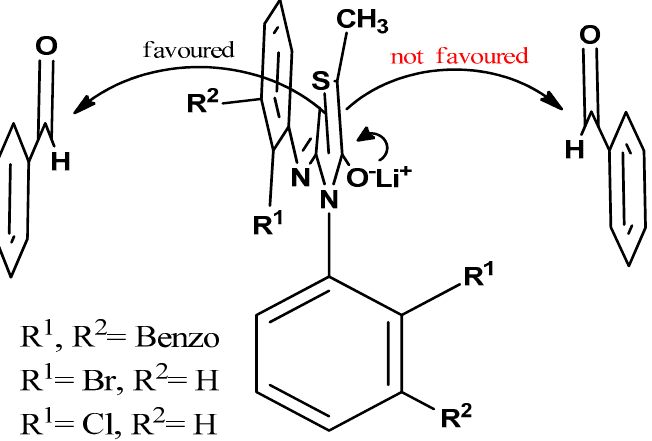
Figure 3. The attack of the axially chiral racemic enolate to the electrophile is favored by the unhindered face rendering face selectivity.